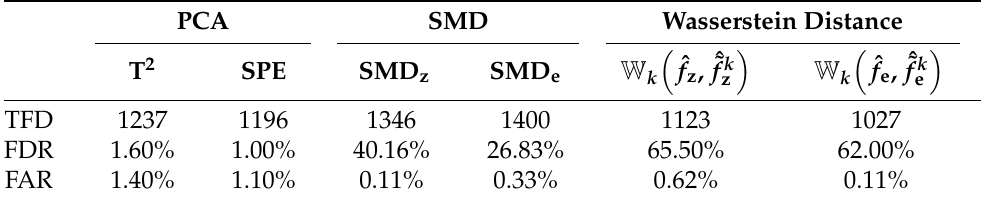
Table 3. Comparison of fault detection performance on